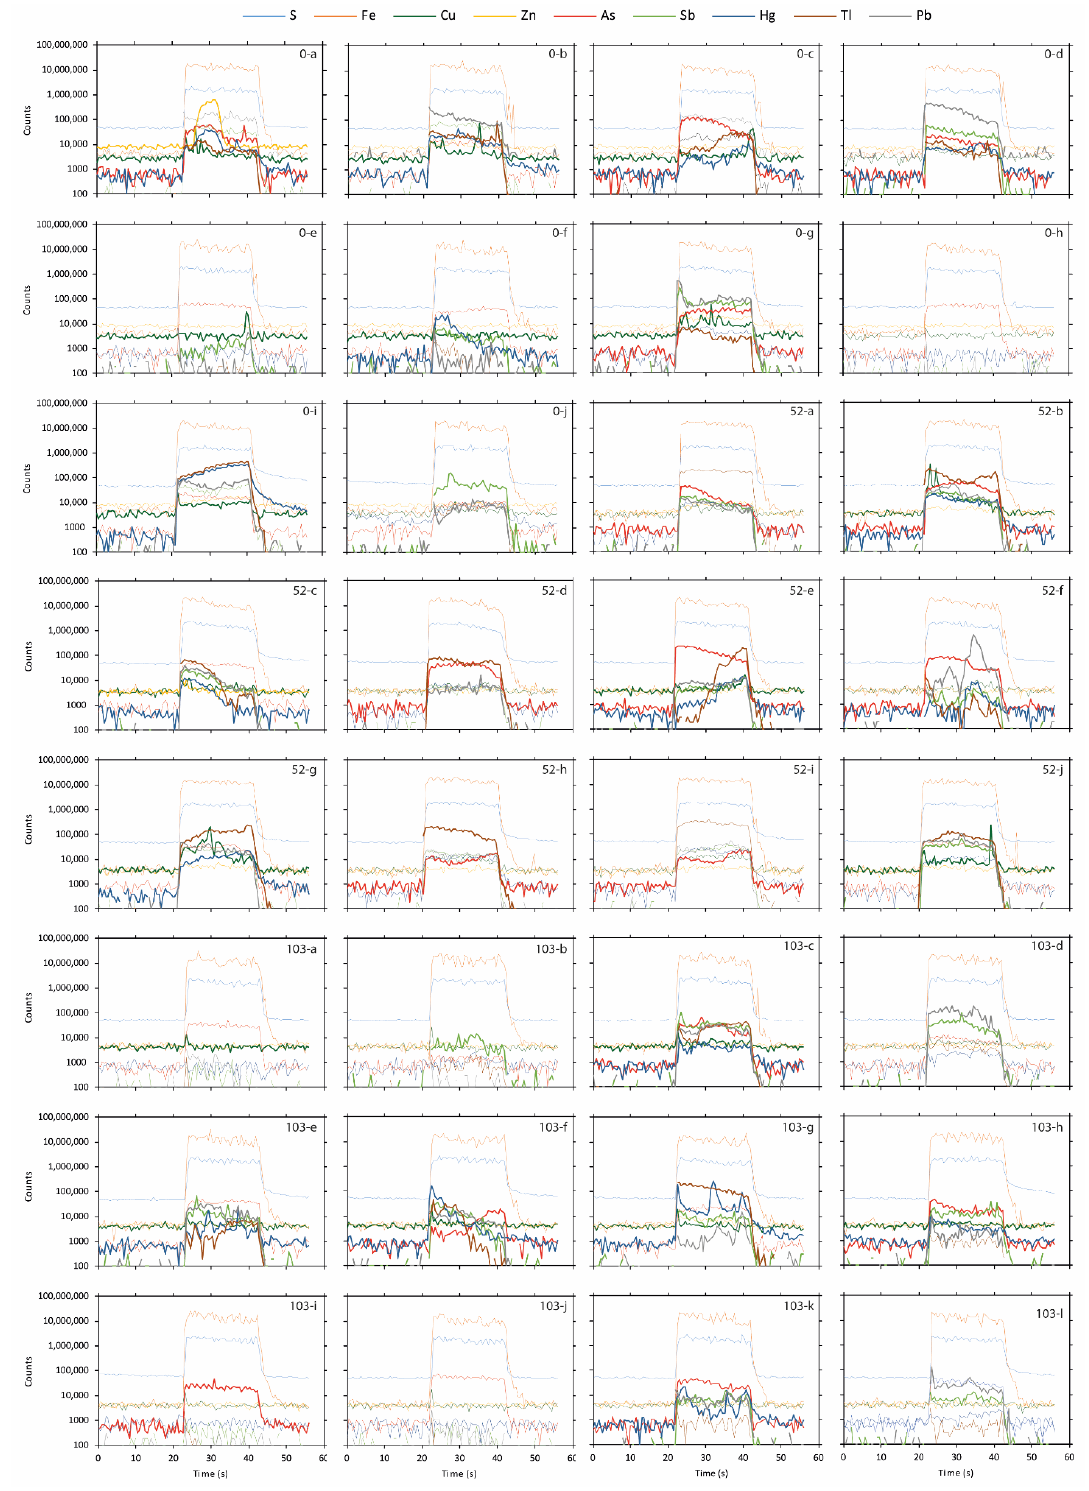
Figure 6. LA-ICP-MS element distribution with time showing how the association of As, Cu Hg, Sb, Pb, Tl, and Zn change with depth in spots measured in the initial sulfidic waste rock (Figure 2).